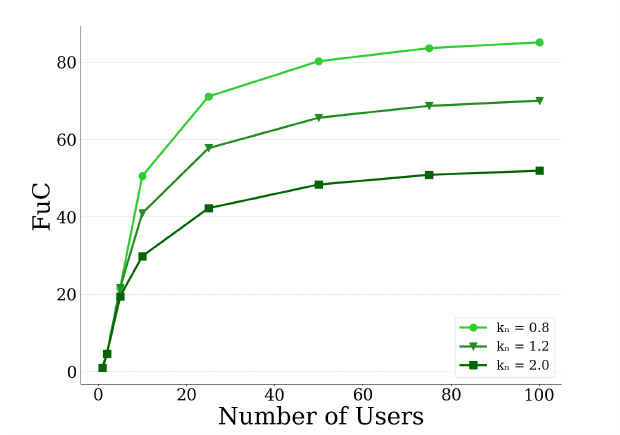
Figure 15. Fragility under Competition vs. no. of users for different loss aversion indices k n